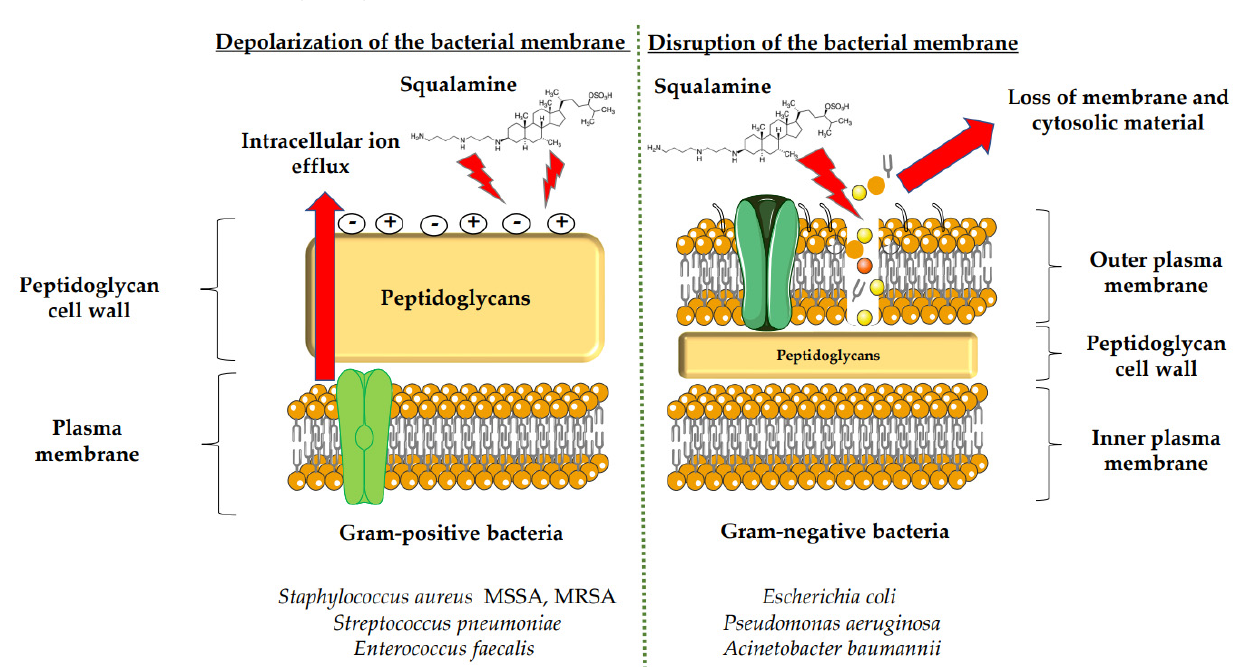
Figure 1. Mechanisms of action of squalamine in Gram-positive and Gram-negative bacteria.